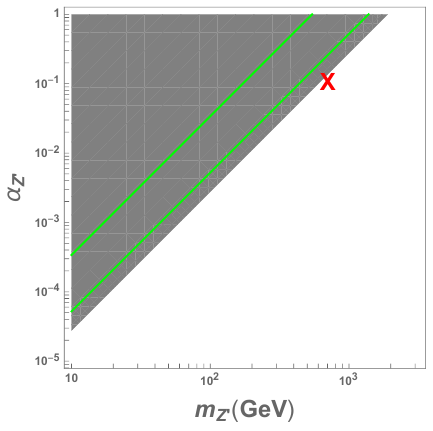
2 in ( m Z 0 ; (cid:11) Z 0 ) plane. (cid:0)